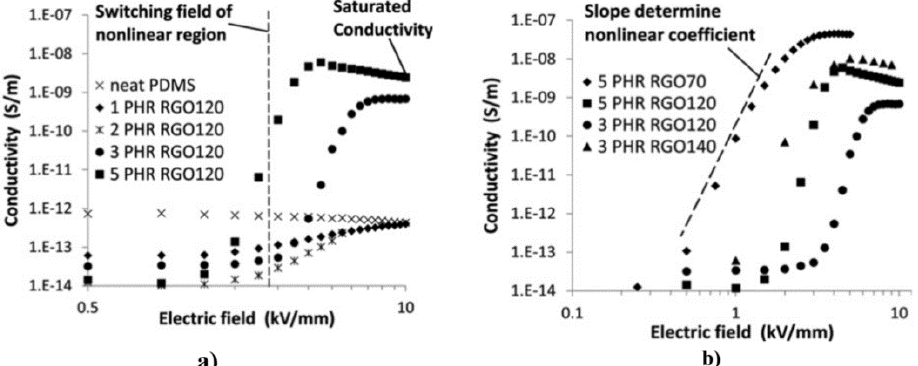
Figure 28. Conductivity vs. field strength for ( a ) composites with different filler contents of GO reduced at 110 °C and ( b ) composites with GO reduced at different temperatures. Reprinted with permission from [88]. Copyright 2012 John Wiley and Sons.